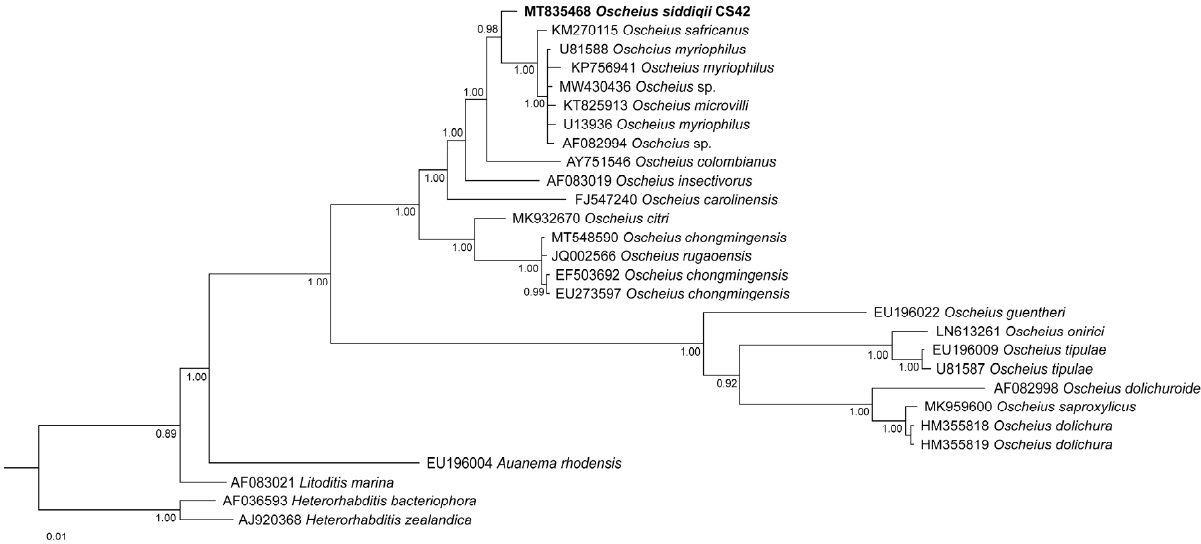
Figure 6. Phylogenetic relationships of Oscheius siddiqii and other Oscheius species as inferred from Bayesian analysis of sequences of the small subunit (18S) of the rDNA segment. Bayesian posterior probabilities (%) that are higher than or equal to 60% are provided at each node. The scale bar indicates the number of substitutions per